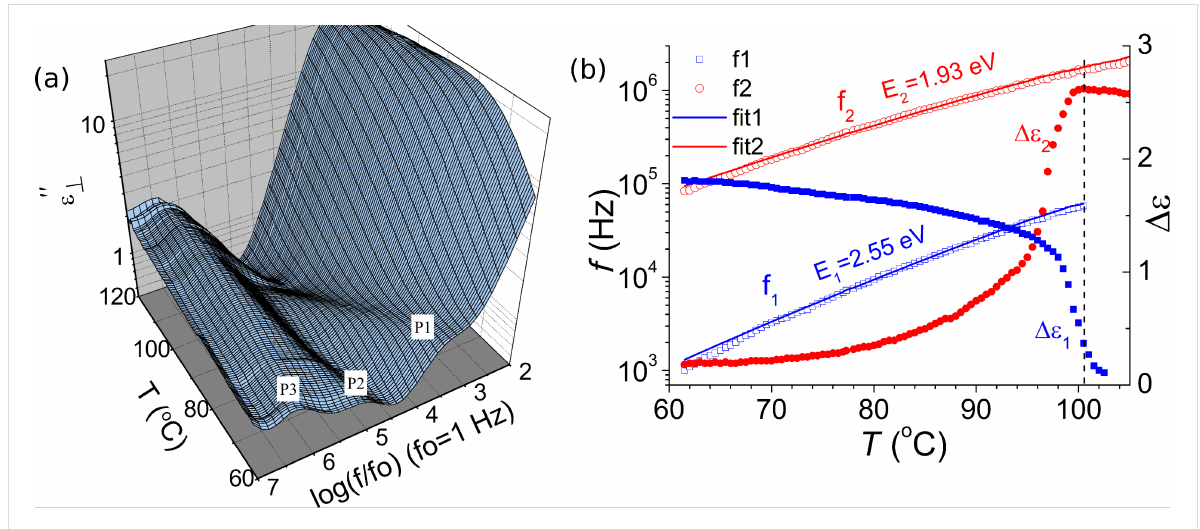
Figure 2: (a) Dielectric loss spectra ( ε″ ) of a planar cell of cell thickness d = 7.8 µm in the frequency range 100 Hz–10 MHz and a temperature range of 60–120 °C. Measurements were carried out upon cooling the sample cell. (b) Temperature dependence of the dielectric strength Δε 1 (filled blue squares) and Δε 2 (filled red circles) and relaxation frequency f 1 (open blue squares), and f 2 (open red circles) are obtained by fitting the dielectric spectra to the Havriliak–Negami equation. Solid lines are fits to the Arrhenius equation, f ( T ) = f 0 exp( − E A / k B T ), where E A is the activation energy.